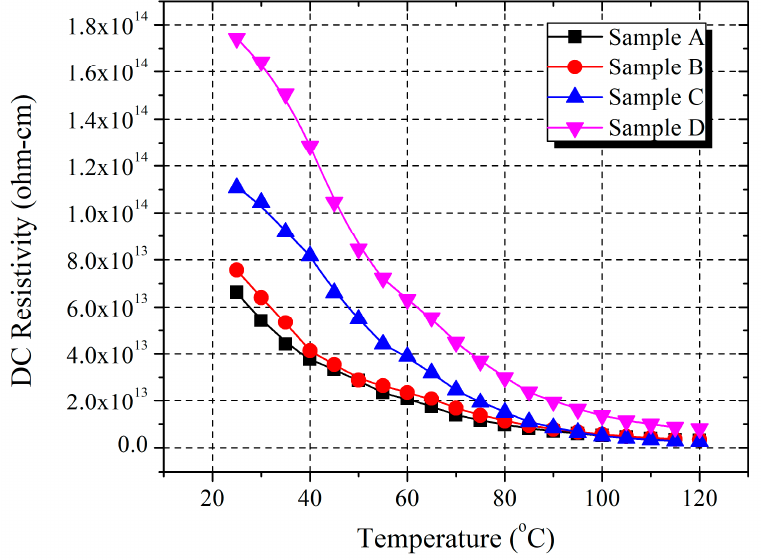
Figure 18. DC resistivity of oil samples at various temperatures.